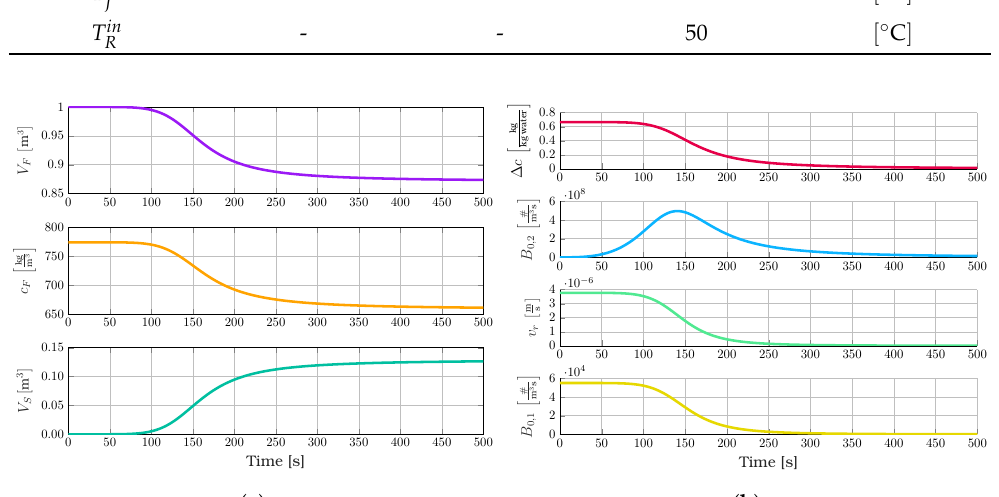
Figure 4. ( a ) The change in V F , c F and V S over time; ( b ) the change in ∆ c , B 0,2 , v r , B 0,1 over time in the case of the isothermal batch system.